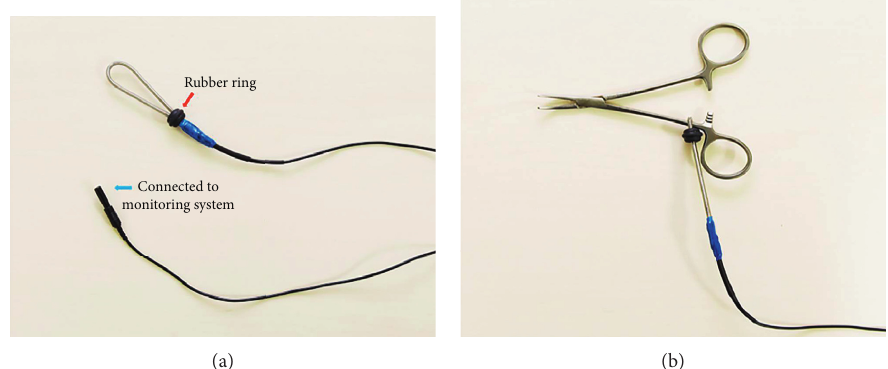
Figure 1: An attachable ring stimulator with a rubber ring for tightening (red arrow) (a). An attachable ring stimulator attached to mosquito forceps (b).